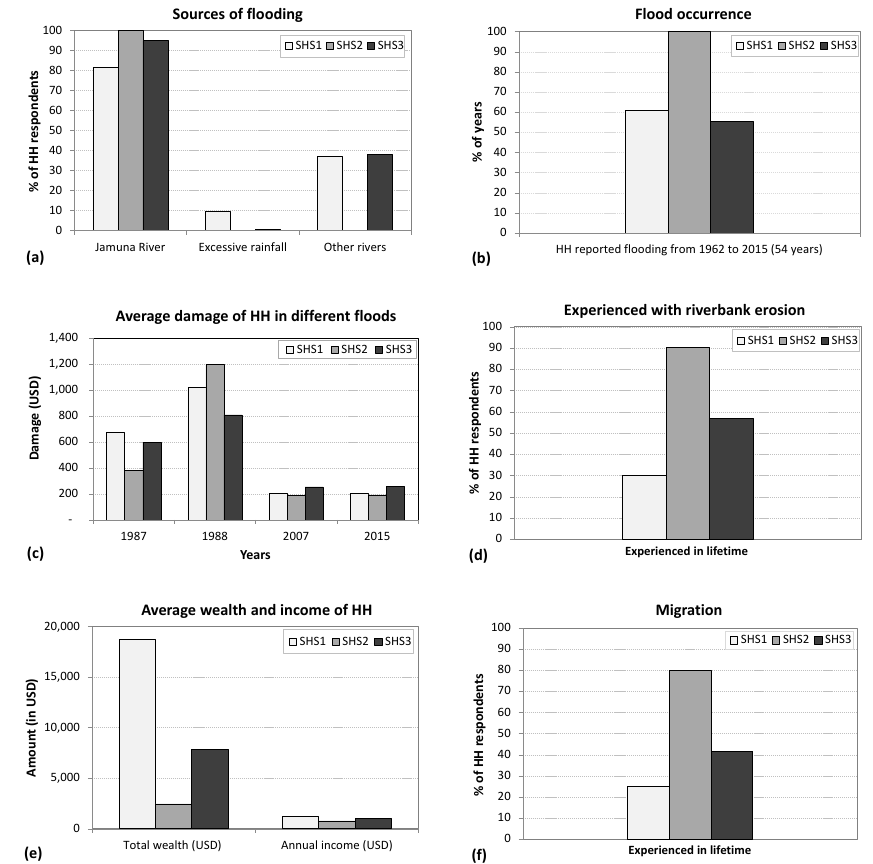
Figure 4. Comparison in between different socio-hydrological spaces (HH =